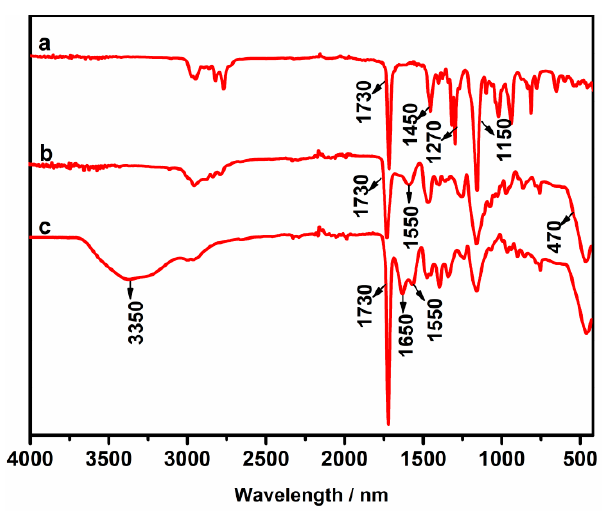
Figure 3. FTIR spectra of (a) PDMAEMA; (b) ZnO@PDMAEMA NPs, and (c) ZnO@PC 400 D 400 NPs.